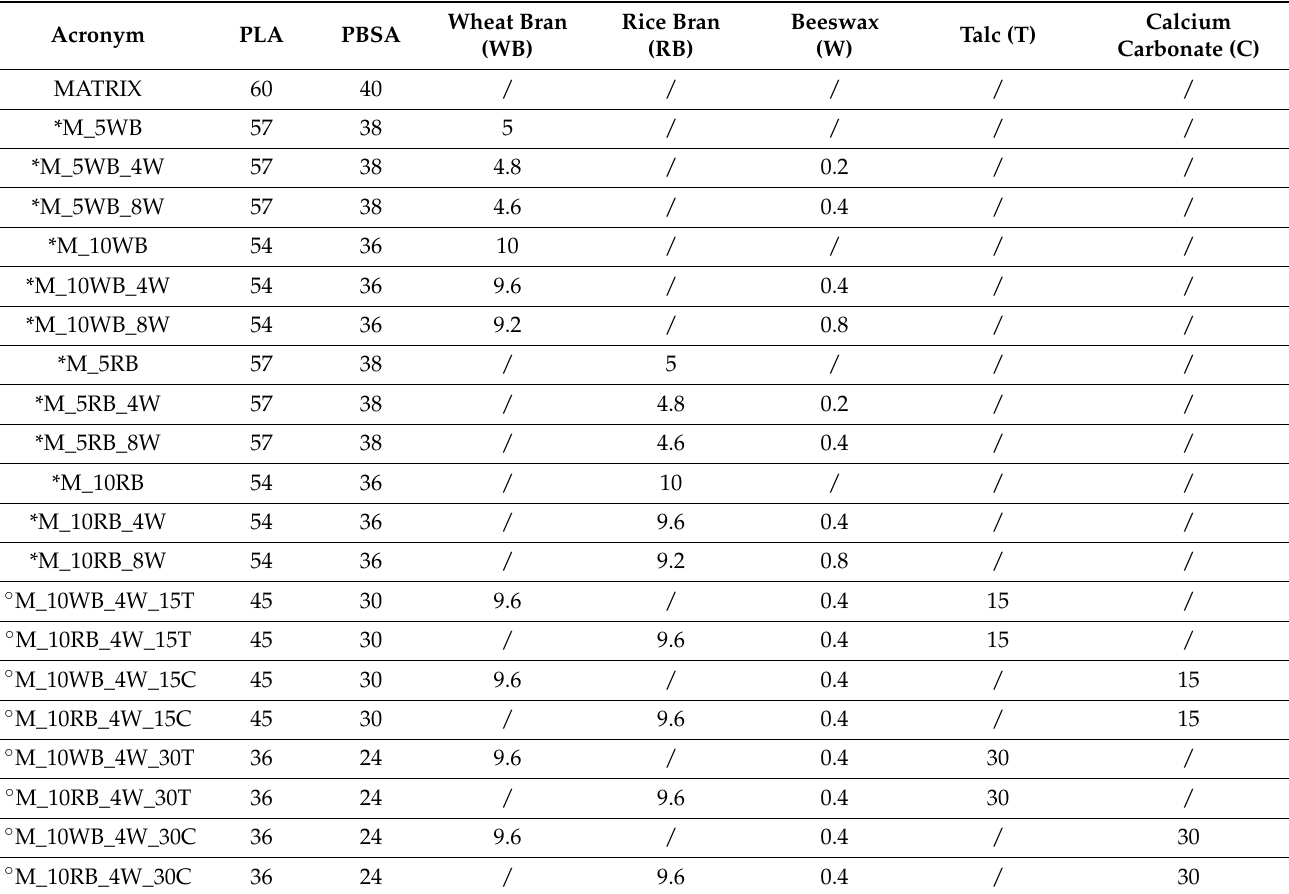
Table 1. Mass composition (wt.%) of studied